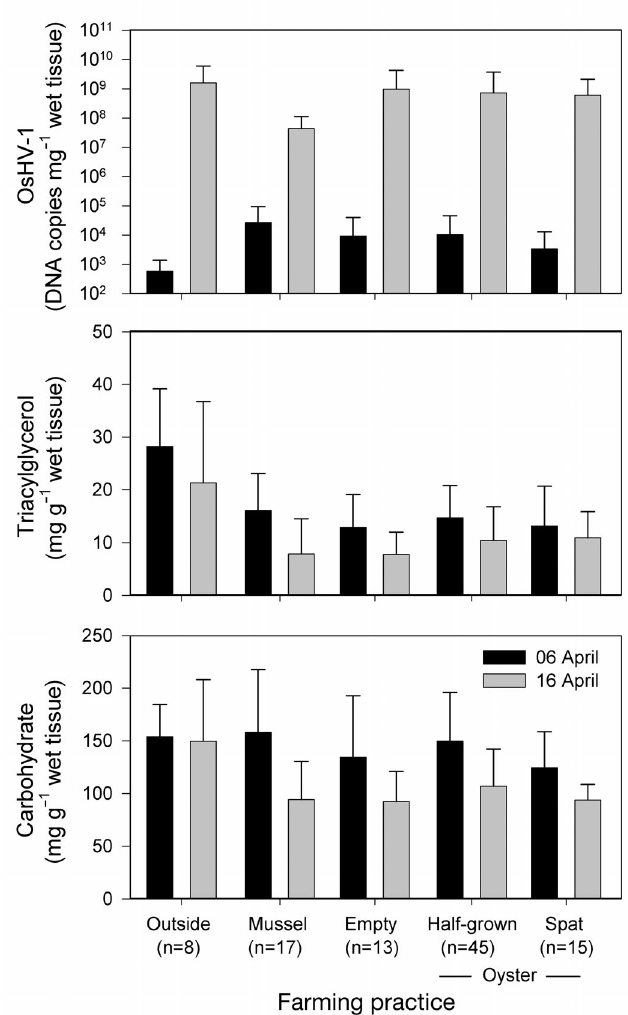
Fig. 3. Ostreid herpesvirus 1 (OsHV-1), triacylglycerol and carbohydrate levels of oysters Crassostrea gigas according to farming practices and time that sentinel oysters were left in place in the Thau lagoon. Data are means + SD of 10 pooled oysters; numbers in parentheses indicate the number of experimental units (or locations) in each